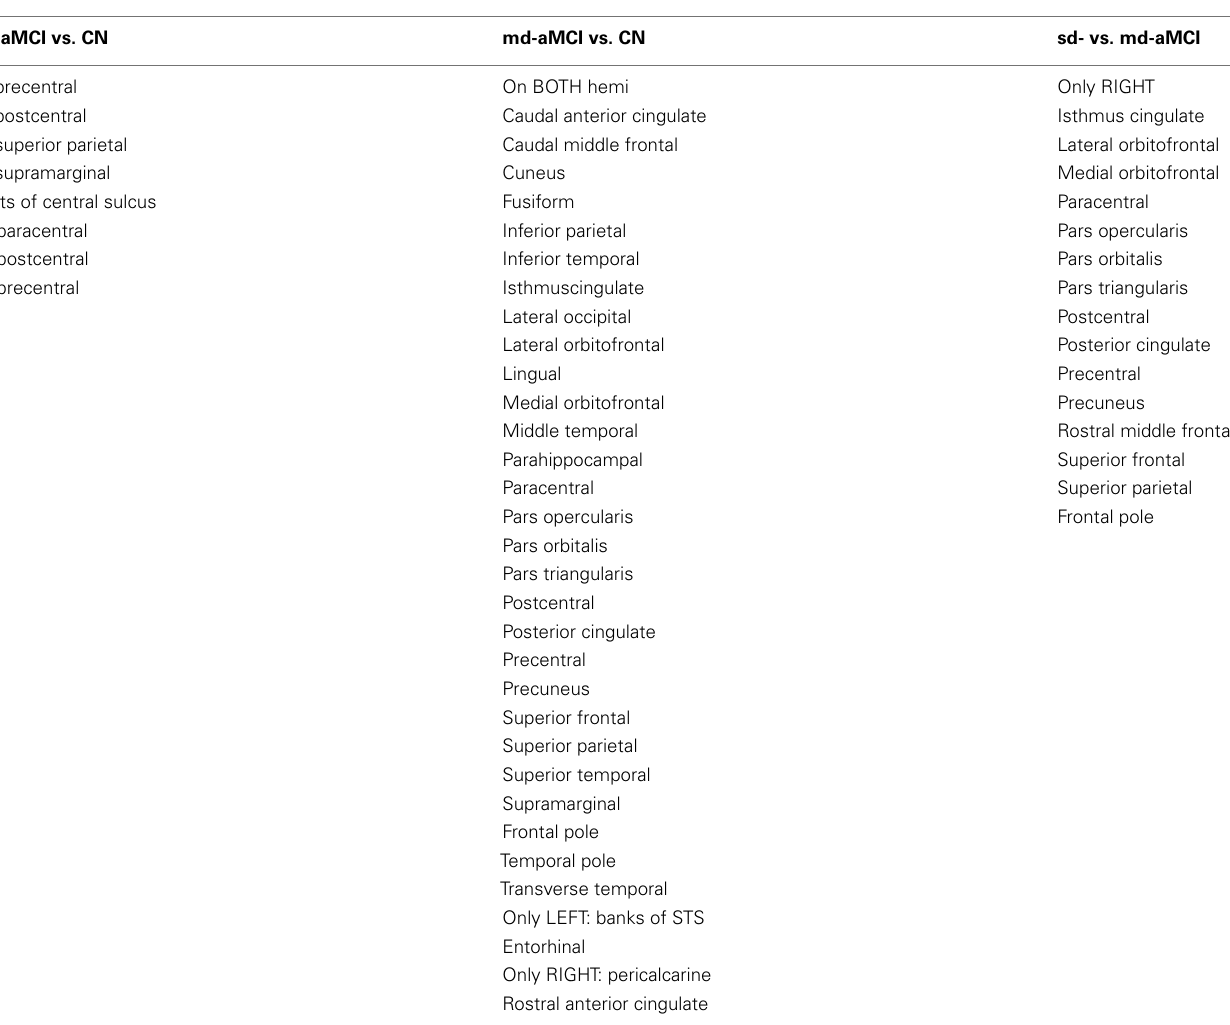
TableA2 | Comparison of the cortical locations in the brain found to be significantly different between the three different pairs from the current study